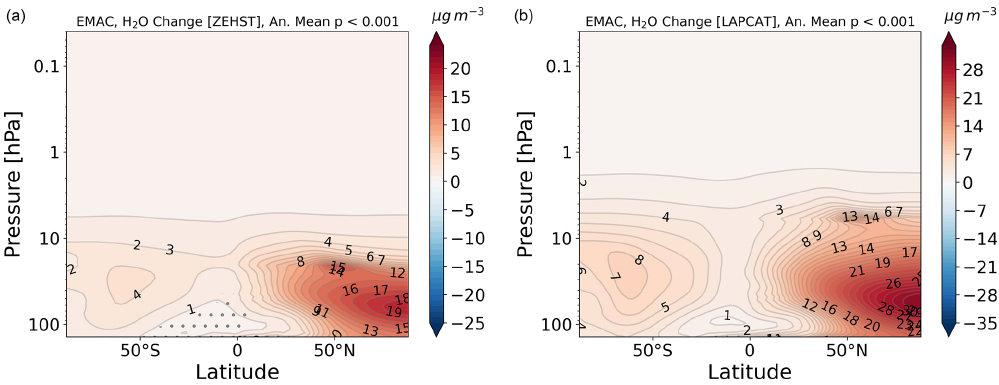
Figure A3. Multi-annual mean (2010–2014) of H 2 O-perturbation [µgm − 3 ] for the ZEHST scenario (a) and the LAPCAT scenario (b) . Dotted areas represent probabilities larger than 0.1% for data not to be significant (standard t test). Horizontal lines represent respective cruise altitudes.